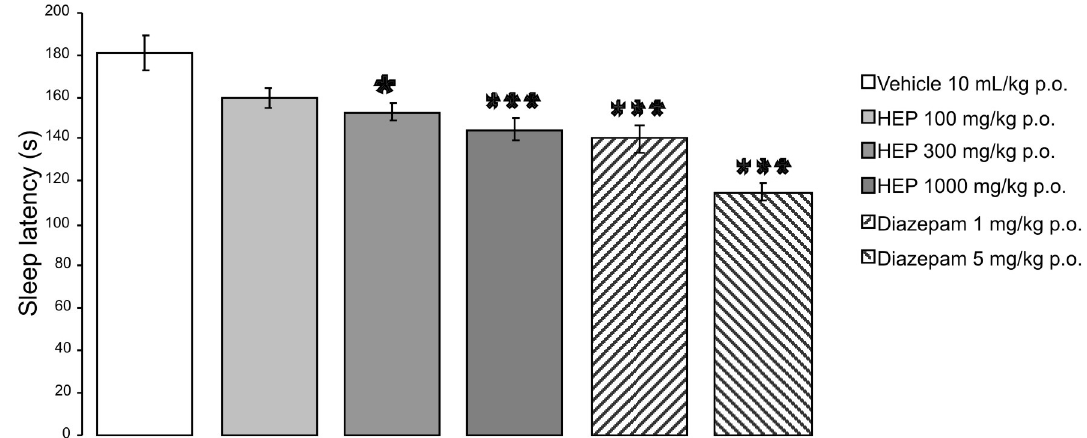
FIGURE 1 - Effect of hydroalcoholic extract from Lafoensia pacari on sleep latency (s) in pentobarbital-induced sleep time test in mice (n = 9) pre-treated (60 min, p.o.) with vehicle (saline, 10 mL/kg), hydroalcoholic extract from Lafoensia pacari stem bark (HEP, 100, 300 or 1000 mg/kg) or diazepam (DZP, 1 or 5 mg/kg). The columns and vertical bars express means ± SEM. * p ≤ 0.05, ** p ≤ 0.01, *** p ≤ 0.001 compared with control group.